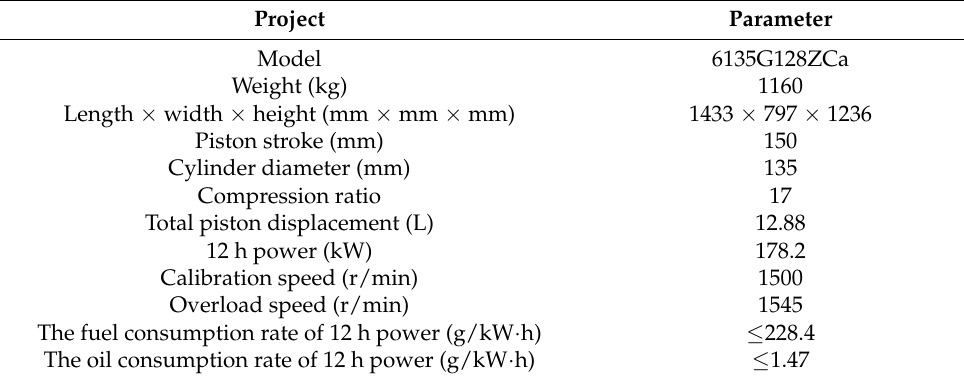
Table 1. The detailed specifications of the